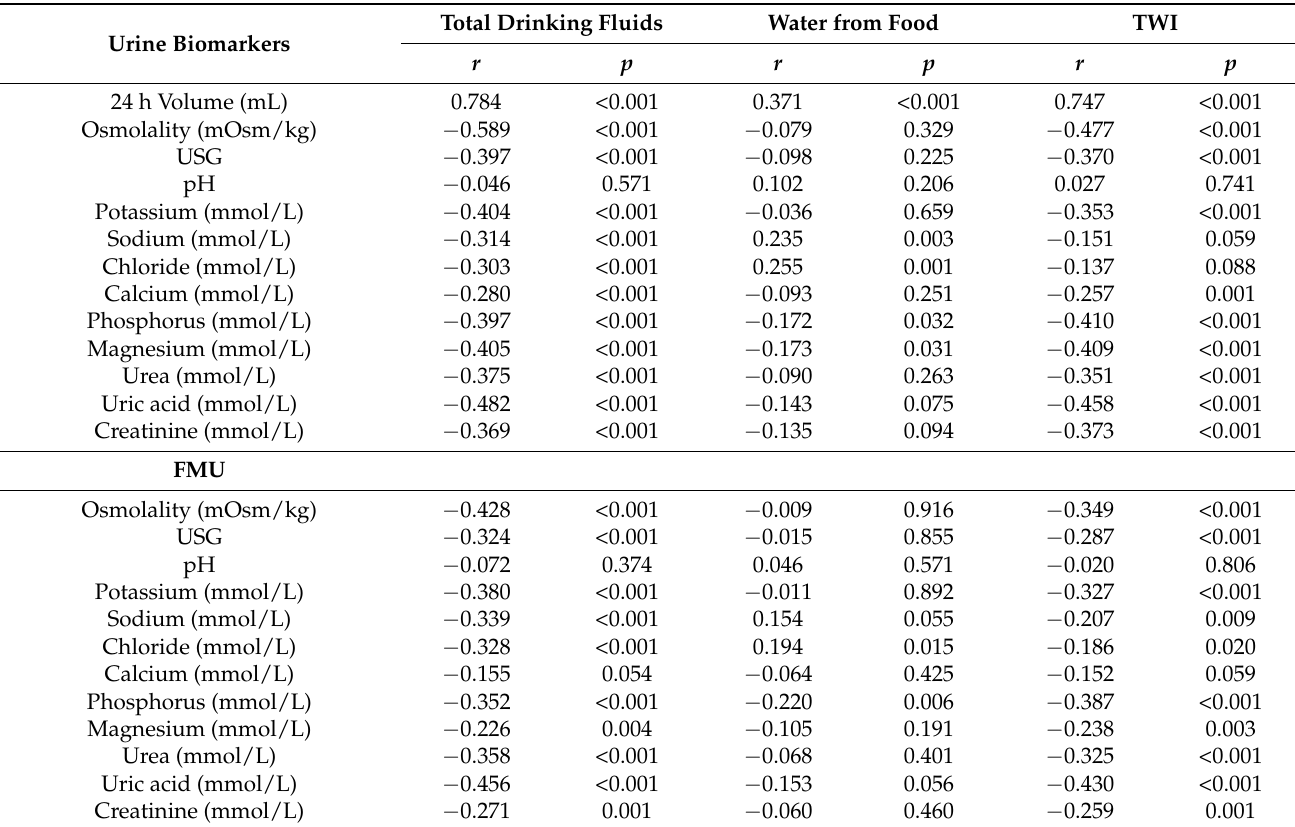
Table 1. Correlations between the fluid intake and urinary biomarkers of young adults.